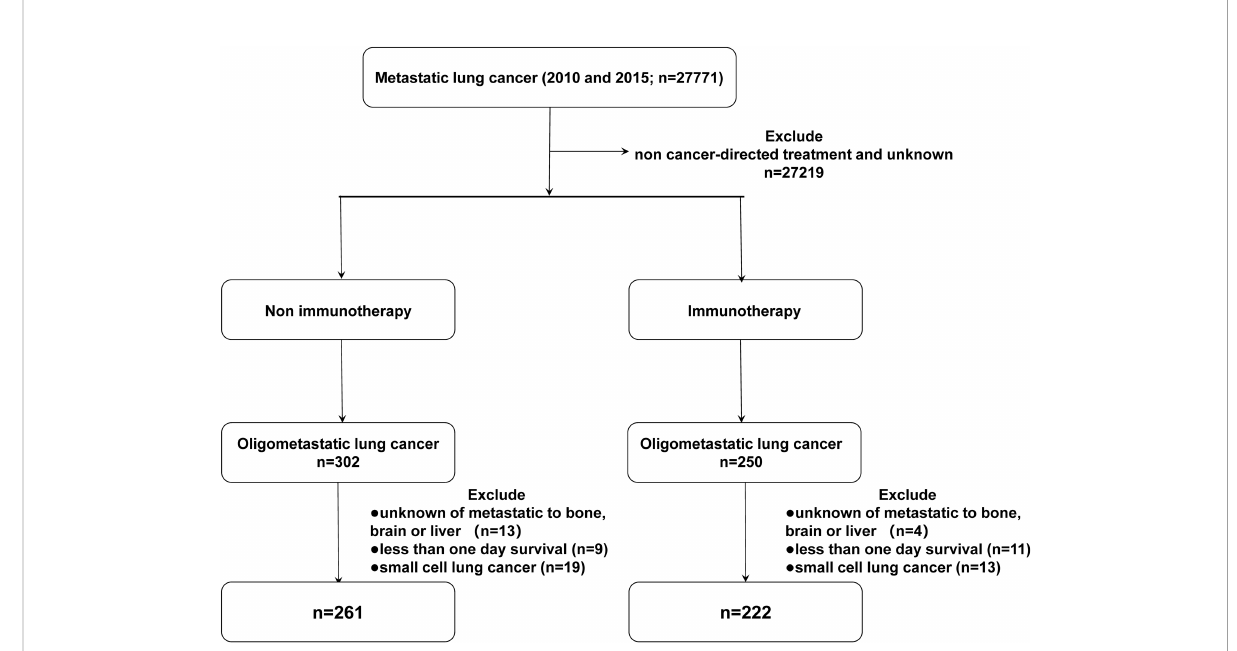
FIGURE 1 Flow diagram of the patient selection process from the SEER